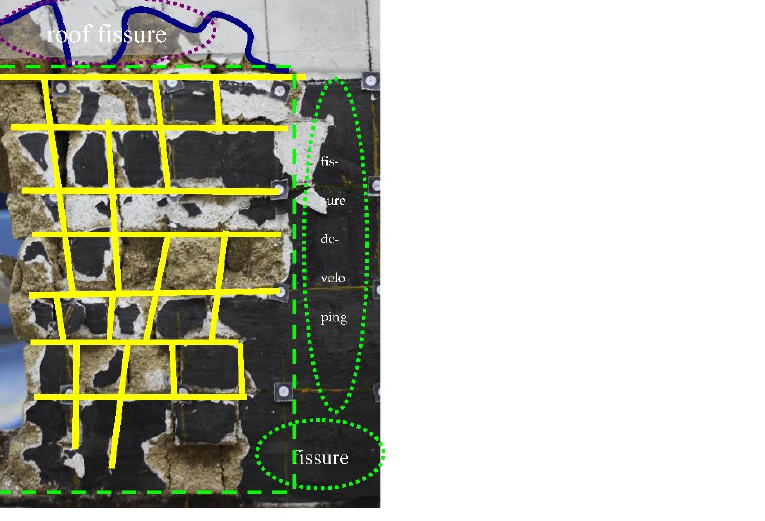
Figure 11. Development of joint and instability form the coal wall rib-spalling ( α = 90°, through